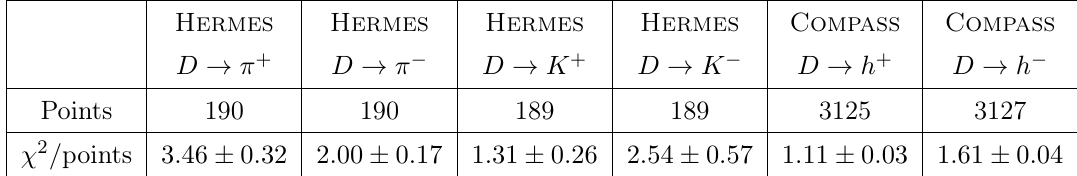
Table 7 . Number of points analyzed and (cid:31) 2 values for SIDIS off a deuteron